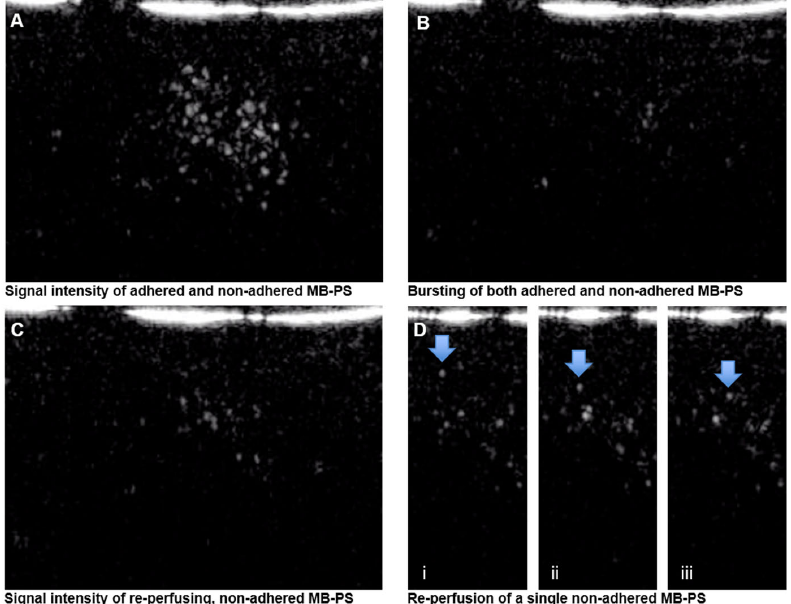
Figure 6. Acquisition of phosphatidylserine ‐ shelled microbubble (MB ‐ PS) signal using contrast ‐ enhanced ultrasonography (CEUS). ( A ) Signal intensity of both adhered and non ‐ adhered MB ‐ PS. ( B ) Bursting of all MB ‐ PS in the frame of view using a high ‐ frequency beam from the ultrasound probe. ( C ) Reperfusion of non ‐ adhered MB ‐ PS. ( D ) Reperfusion of a single MB ‐ PS (arrows) into the intervillous space after bursting of MB ‐ PS across three sequential frames (i–iii). We calculated the MB ‐ PS signal intensity of the adhered bubbles by subtracting panel ( C ) from panel ( A ) to only provide the signal of adhered MB ‐ PS.